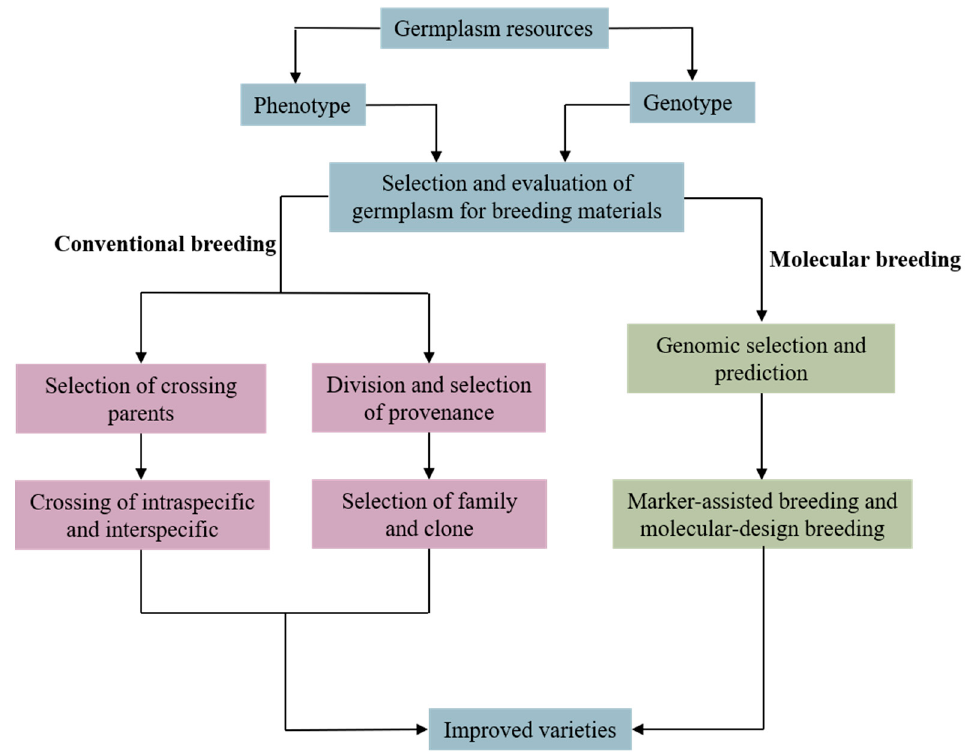
Figure 2. Genetic improvement strategies for Pinus koraiensis.